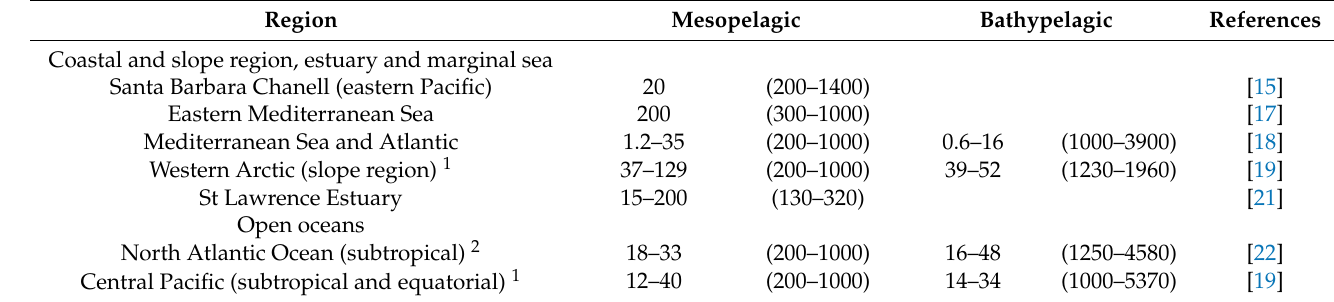
Table 1. TEP concentrations ( µ g Xeq. L − 1 ) in the meso- and bathypelagic layers. Values in parentheses are the depth range in